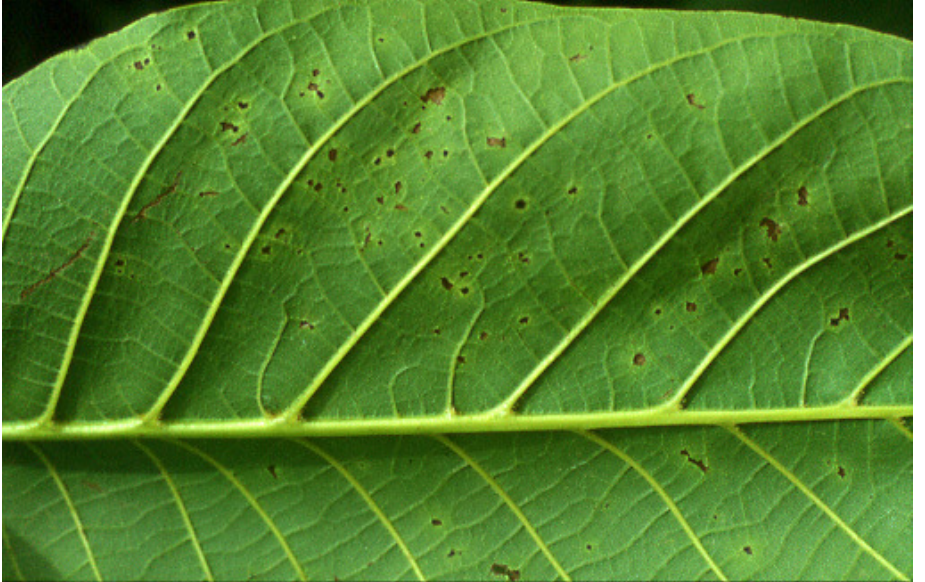
Figure 1. Leaf spotting caused by Xanthomonas arboricola pv . juglandis on Juglans